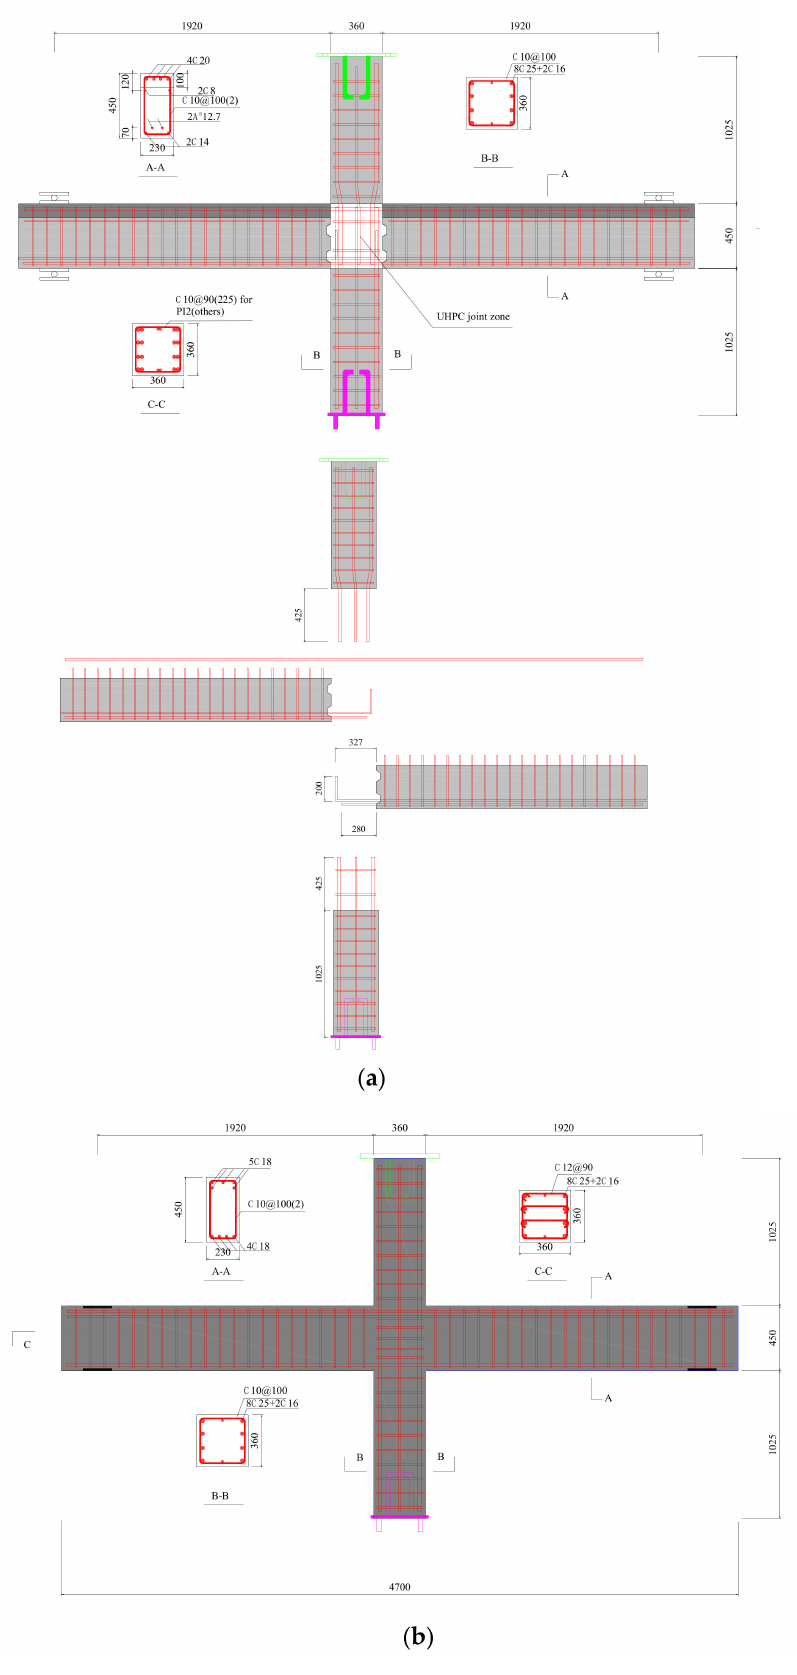
Figure 1. Reinforcement details of specimens. ( a ) UHPC precast specimens, ( b ) monolithic RC